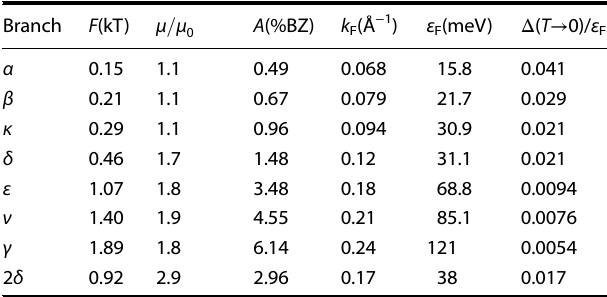
Table 1. Summary of experimental data extracted from both the de- Haas-van-Alphen and the